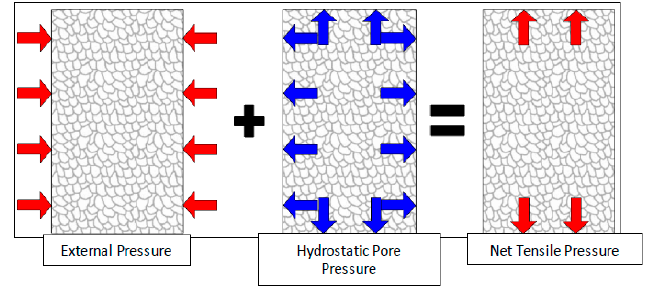
Figure 2. Pressure tension effect [2].